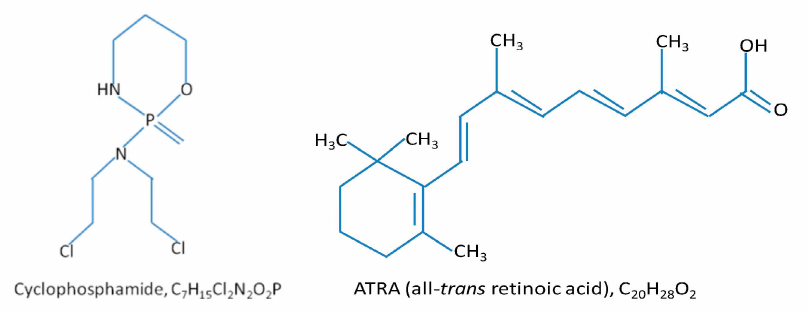
Figure 9. Chemical structures of cyclophosphamide and